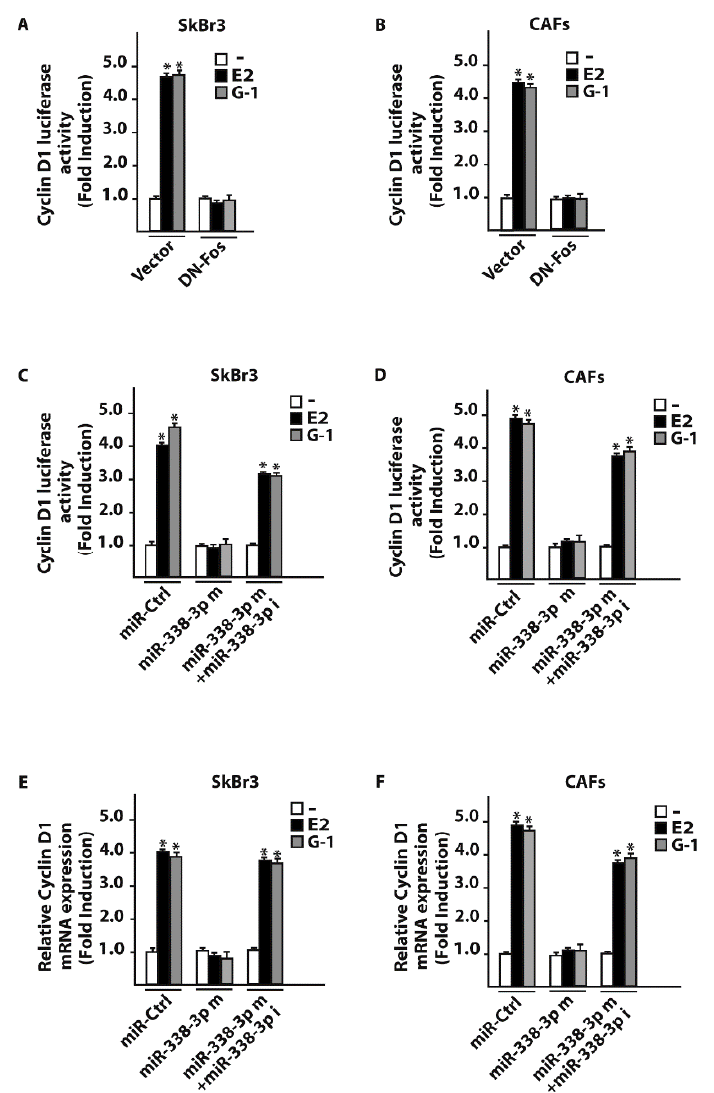
Figure 7. c-Fos and miR-338-3p are involved in Cyclin D1 regulation in SkBr3 cancer cells and CAFs. Luciferase activity of Cyclin D1 reporter gene in SkBr3 cancer cells ( A ) and CAFs ( B ) transfected for 8 h with a vector or a dominant-negative c-Fos construct (DN-Fos) before treatment with 100 nM of E2 and 100 nM G-1 for 18 h. Luciferase activity of Cyclin D1 reporter gene in SkBr3 cancer cells ( C ) and CAFs ( D ) transfected for 24 h with 25 nM miR-Ctrl or miR-338-3p mimic (miR-338-3p m) in combination or not with 50 nM miR-338-3p inhibitor (miR-338-3p i) before treatment for 18 h with 100 nM E2 or 100 nM G-1. The luciferase activity was normalized to the internal transfection control, values of cells receiving vehicle (-) were set as 1-fold induction upon which the activity obtained upon the indicated treatments was calculated. mRNA expression of Cyclin D1 in SkBr3 cells ( E ) and CAFs ( F ) transfected for 48 h with 25 nM miR-Ctrl or miR-338-3p mimic (miR-338-3p m) in combination or not with 50 nM miR-338-3p inhibitor (miR-338-3p i) before treatment for 8 h with 100 nM E2 or 100 nM G-1. Each column represents the mean ± SD of three independent experiments performed in triplicate. (*) indicates p < 0.05 for cells receiving treatments vs cells treated with vehicle (-).